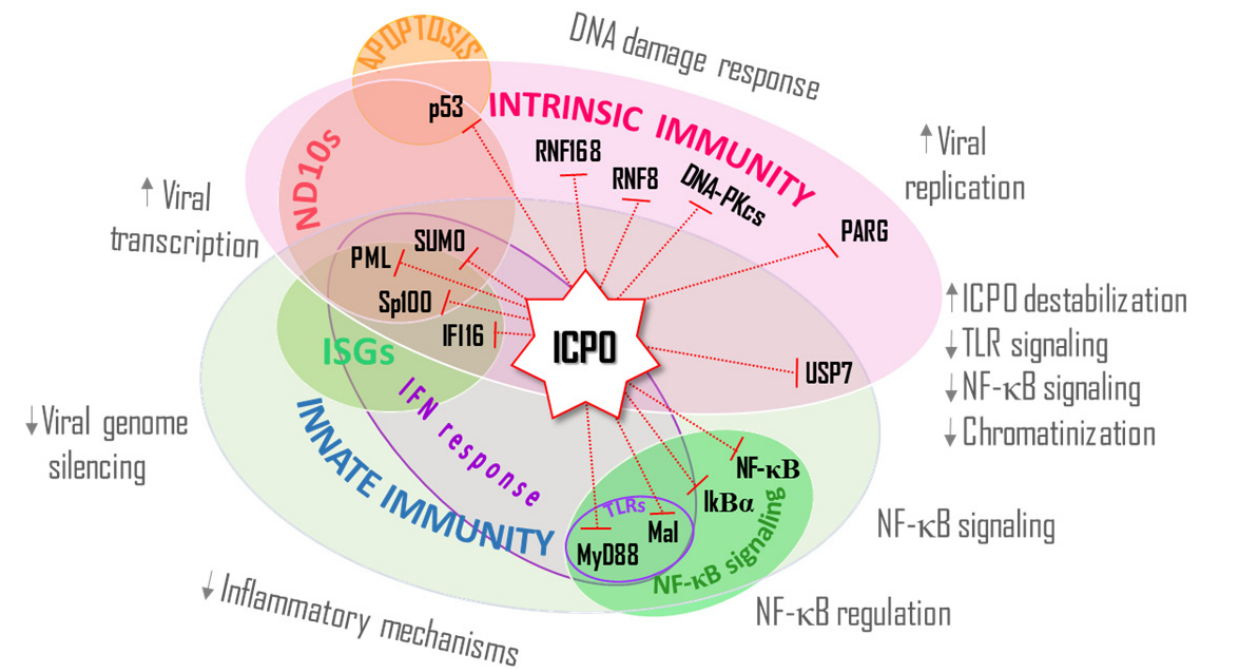
Figure 2. The HSV-1 ICP0 E3 ubiquitin ligase activity counteracts components of host intrinsic and innate immunity by targeting the degradation or dissociation of specific cellular proteins. Many ICP0 targets are multi-functional and participate in both intrinsic and innate antiviral responses and affect several processes, which includes ( 1 ) Viral transcription: PML, Sp100, and SUMO; ( 2 ) Viral genome silencing: IFI16; ( 3 ) Inflammatory mechanisms and NF- κ B regulation: IFI16, MyD88, Mal, NF- κ B, and I κ B; ( 4 ) Viral replication: PARG; ( 5 ) DNA damage response: RNF168, RNF8, and DNA-PKcs; and ( 6 ) ICP0 destabilization, TLR signaling, Chromatinization, NF- κ B signaling: